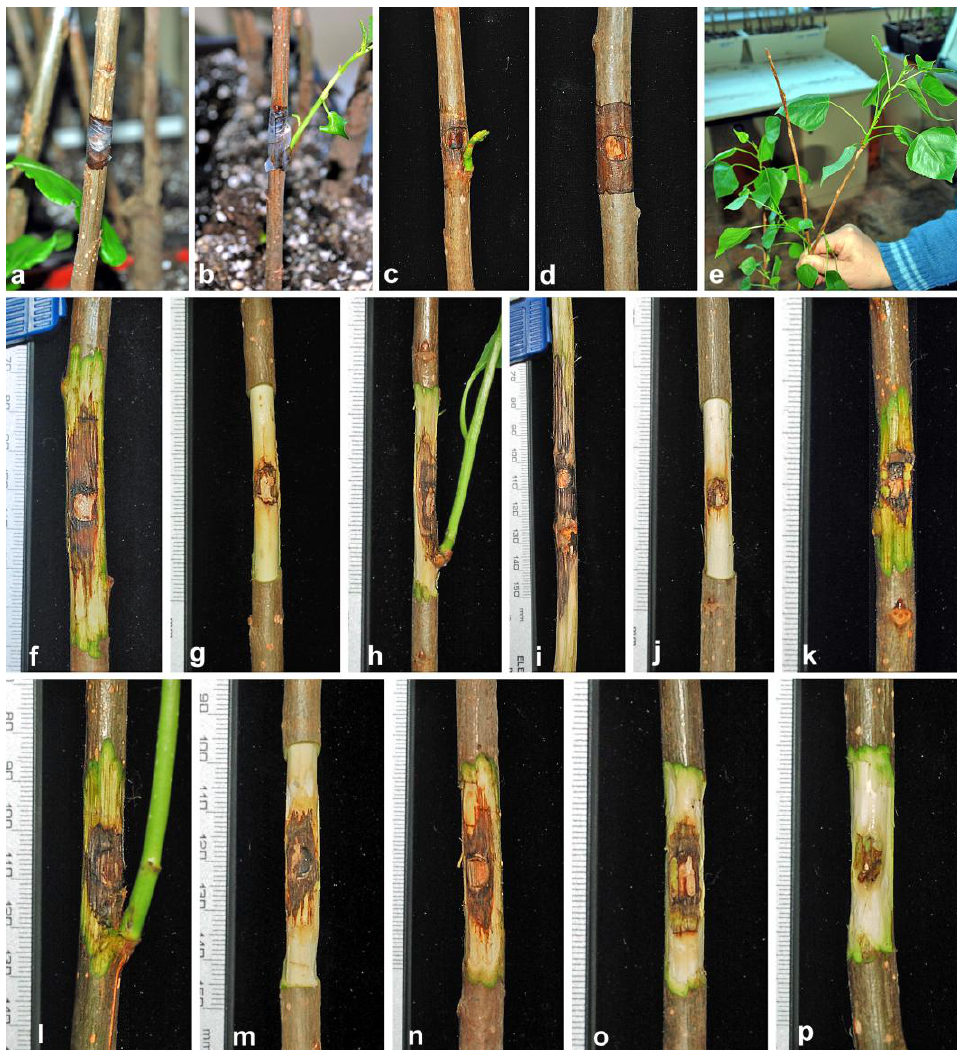
Figure 5. Representative symptoms caused by seven Phytophthora spp. on cuttings of poplar clone P á nnonia in the underbark inoculation test: ( a , b ) bleeding bark lesions after eight weeks: ( a ) P. cactorum ; ( b ) P. lacustris , with formation of secondary shoot. ( c , d ) necrotic lesions of outer bark after 11 weeks: ( c )